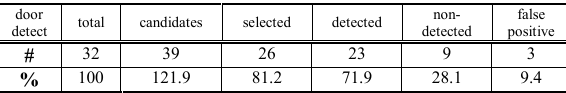
Table 1. Door detection success rates